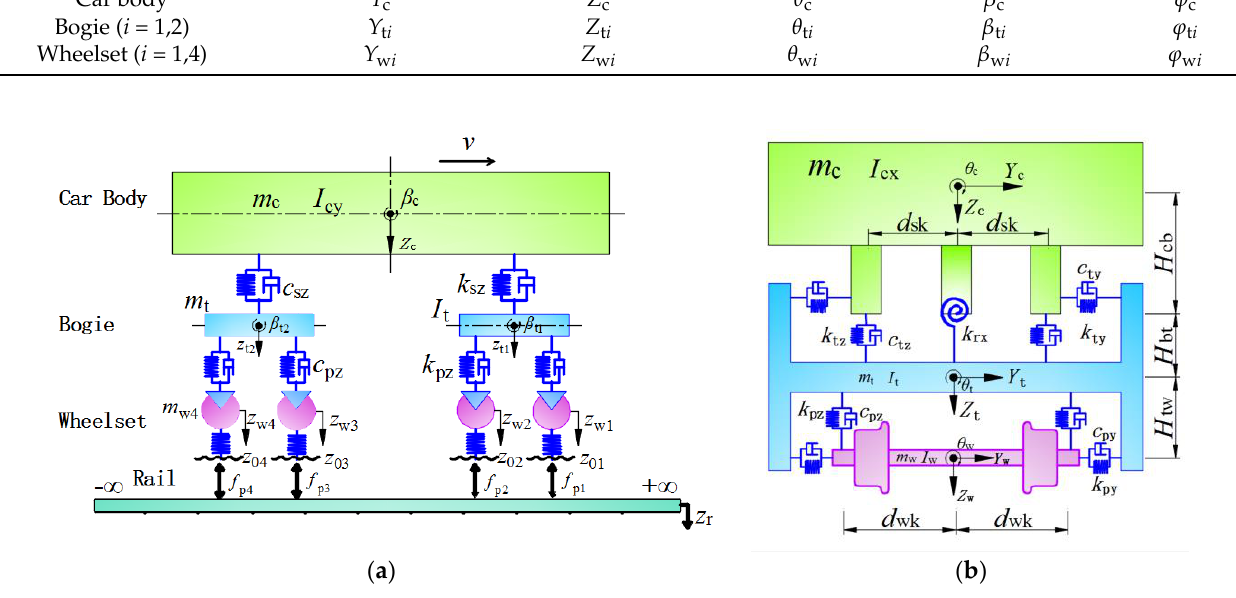
Figure 2. Vehicle dynamic analysis model. ( a ) Side view of vehicle model. ( b ) Front view of vehicle model. vehicle